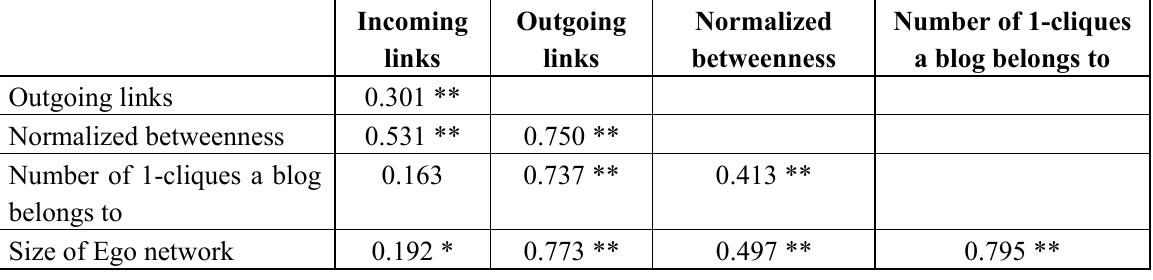
Table 2. Correlation coefficients among the five social network indexes.